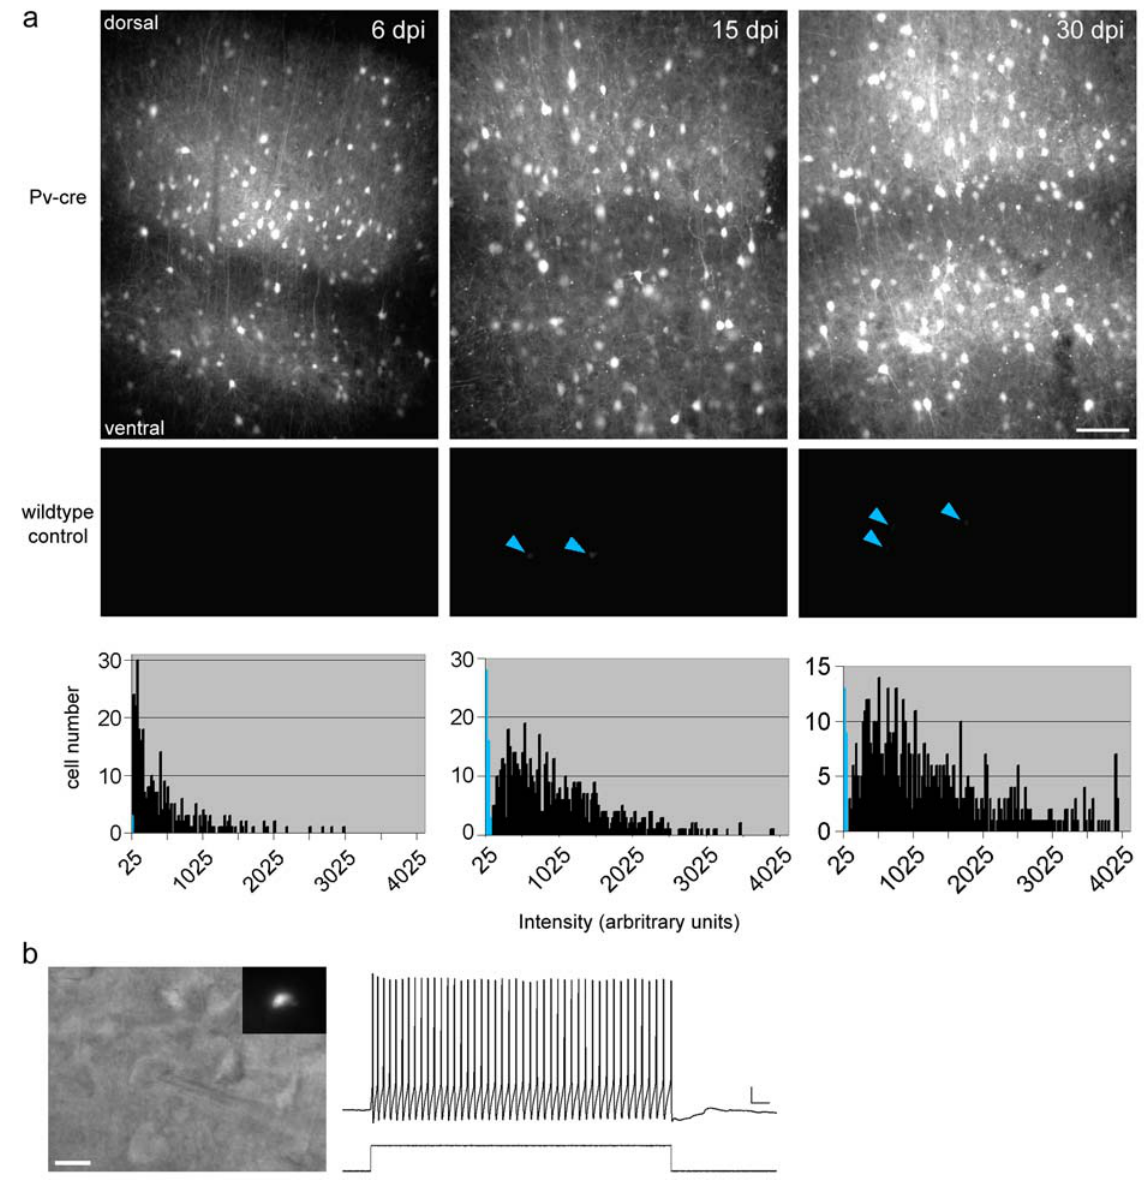
Figure 2. GFP expression in Pv-cre mice injected with AAV-LS 1 L-GFP is stable for months. (a) Pv-cre mice (top row; n=3 mice for each time point) and wildtype control mice (middle row; n=3 mice for each time point) were injected with AAV-LS 1 L-GFP and were perfused at 6,15,30, and 60 days post-injection (dpi). See Figure S3 for 60 dpi. All epi-fluorescence images were acquired with a CCD camera using the same acquisition parameters. The maximum exposure time that did not lead to saturation of signal was used (75 ms), and the same look-up table was applied to all of the images shown. GFP expression levels increased with time in Pv-cre mice. Under these conditions, sparse weak signals were detected in some wildtype control mice (blue arrowheads); scale bar, 100 m m. Bottom row, quantification of GFP intensity at somata of labeled neurons plotted for wildtype control mice (blue) and Pv-cre mice (black). Average number of GFP + cells counted per animal in Pv-cre injected animals was (6,15,30 dpi): 110 + / 2 34, 215.3 + / 2 34, 195.3 + / 2 26 cells. (b) Whole cell current clamp recording of an AAV-LS 1 L-GFP-transfected neuron from a 2.5 month-old Pv- cre mouse at 20 dpi. Left, DIC image of recorded cell; inset shows GFP fluorescence; scale bar, 10 m m. Right, example trace of spikes in response to a 250 pA current step; scale bar, 10 mV, 25